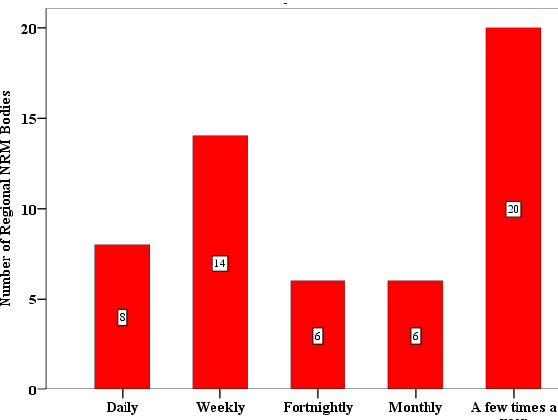
Figure 8. Utilisation of VGI and freely available/accessible spatial products for catchment management